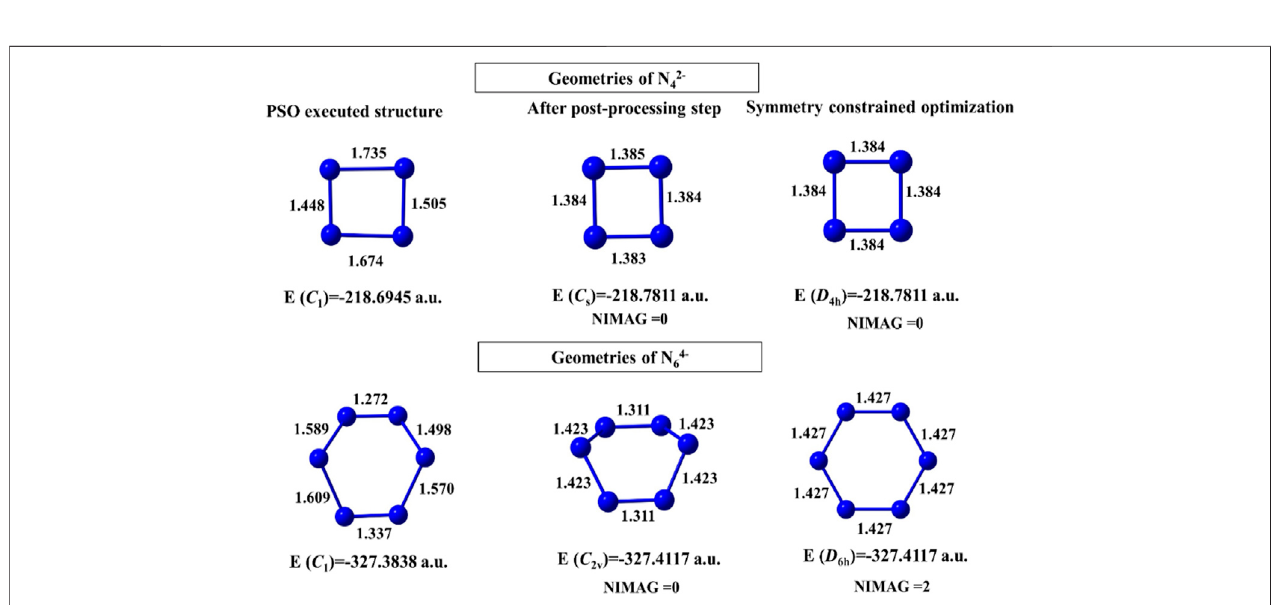
FIGURE 2 | Structures of N 42- and N 64- clusters obtained at the end of the PSO run, post-processing step, and geometry-constrained optimization computed at the B3LYP/6-311+G(d) level. (Reprinted from Mitra et al., 2021 with permission from Theoretical Chemistry Accounts, Springer Nature. Copyright© 2021, Springer- Verlag GmbH,